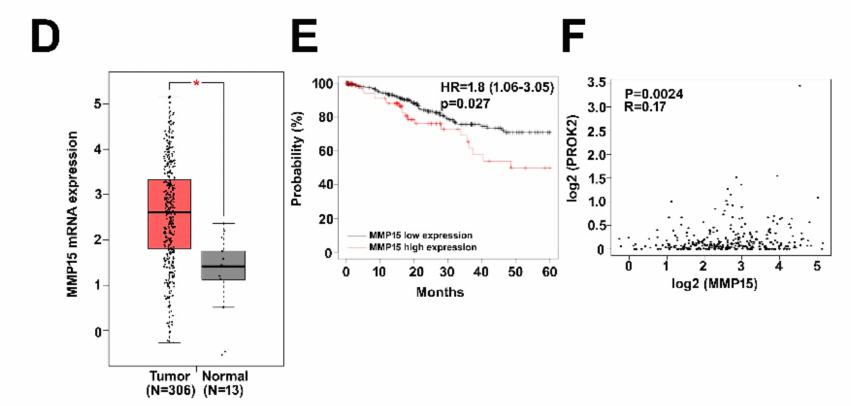
Figure 3. E ff ect of knockdown PROK2 on MMP15 expression and cell invasion in human cervical cancer HeLa cells. ( A ) Human HeLa cells were transfected with or without PROK2 shRNA, then followed by measuring the capacity of cell migration and invasion. ( B , C ) The protein and mRNA expression of MMP15 were inhibited by shPROK2-HeLa cells were measured by western blotting and R-qPCR assay. ( D ) Validation of MMP15 gene expression in matched cervical cancer tissues and adjacent noncancerous cervical tissues from the GEPIA databases. T: cervical tumour tissue ( n = 306); N: normal cervical tissue ( n = 13), * p < 0.05 versus normal cervical tissue. ( E ) Overall survival rate (OS) in patients with high or low MMP15 expression. The red line indicates high expression, and black line indicates low expression. ( F ) MMP15 expression was correlated with PROK2 expression in human cervical cancer patients. ** p < 0.01 versus shLuc